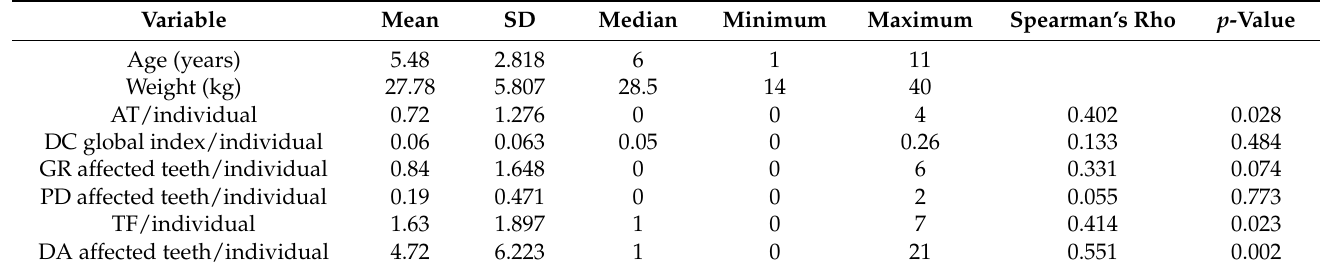
Table 2. Age, weight, and results obtained per individual. AT: absent teeth; DC: dental calculus; GR: gingival recession; PD: periodontal disease; TF: tooth fracture; DA: dental